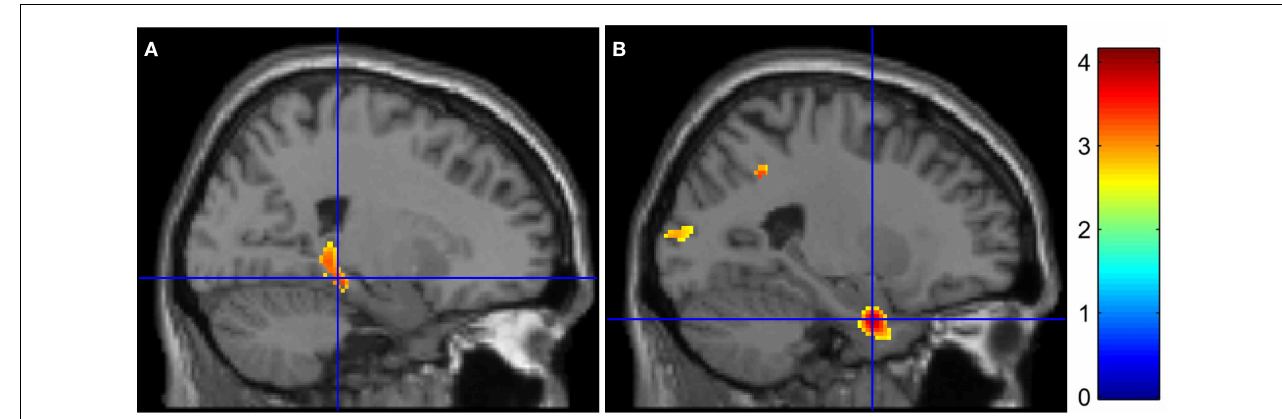
FIGURE 1 | Medial temporal lobe hypoactivations inAD patients for (encoding – reading) and (stem-cued recall – stem-completion) contrasts (respectivelyA and B). The color bar indicates T